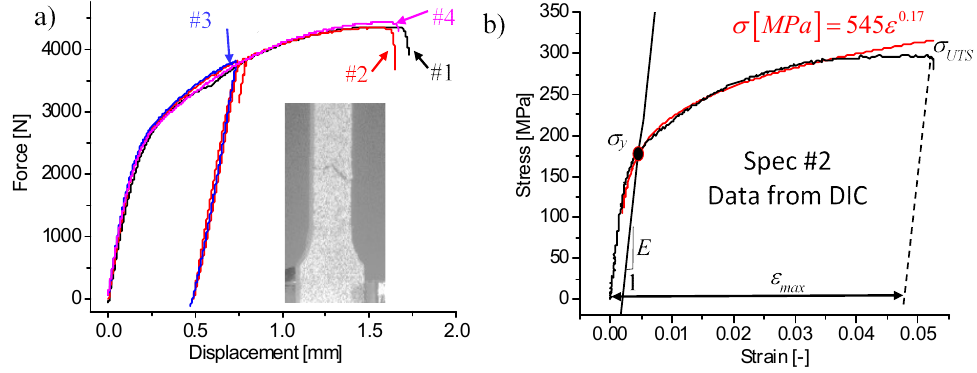
Figure 8. Tensile testing of plain specimens: ( a ) force–displacement diagrams of Specimens #1 and #4 strained to failure, #3 loaded and unloaded, and #2 loaded, unloaded, and strained to failure; ( b ) experimentally measured and Hollomon-approximated stress–strain diagrams of Specimen #2.